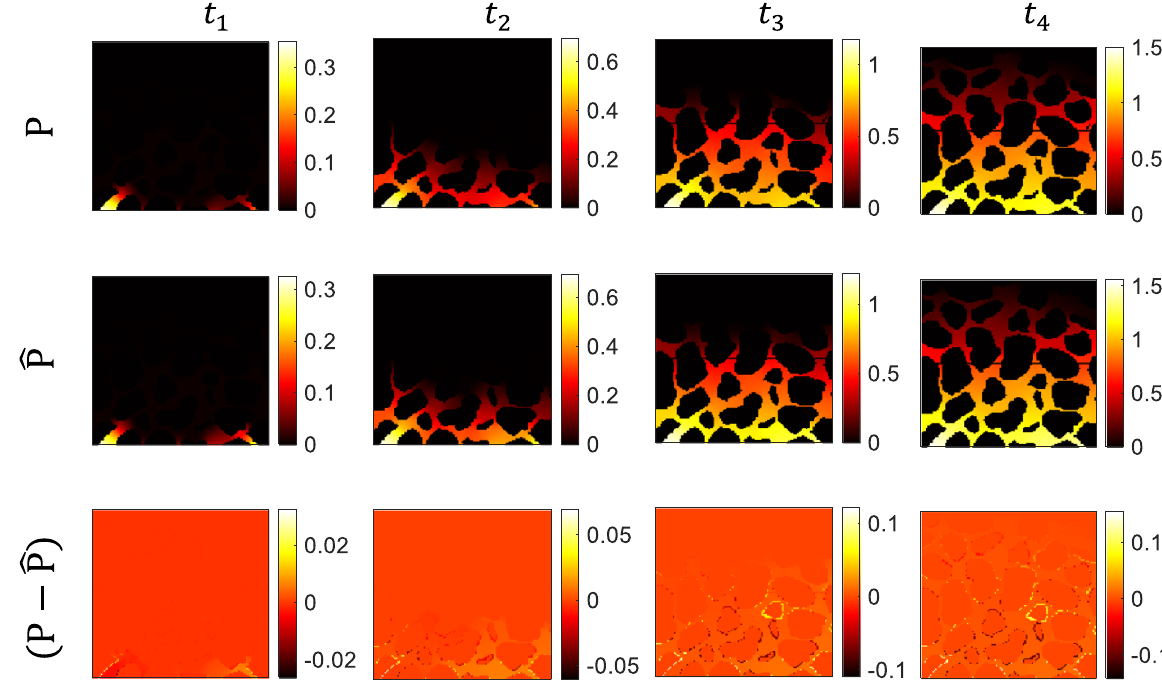
Fig. 8 PIRED predictions for the fl uid pressure in the sandstone. Comparison of the predicted pressure ^ P with the numerically calculated P at four (dimensionless) times in a randomly selected 2D cut of the